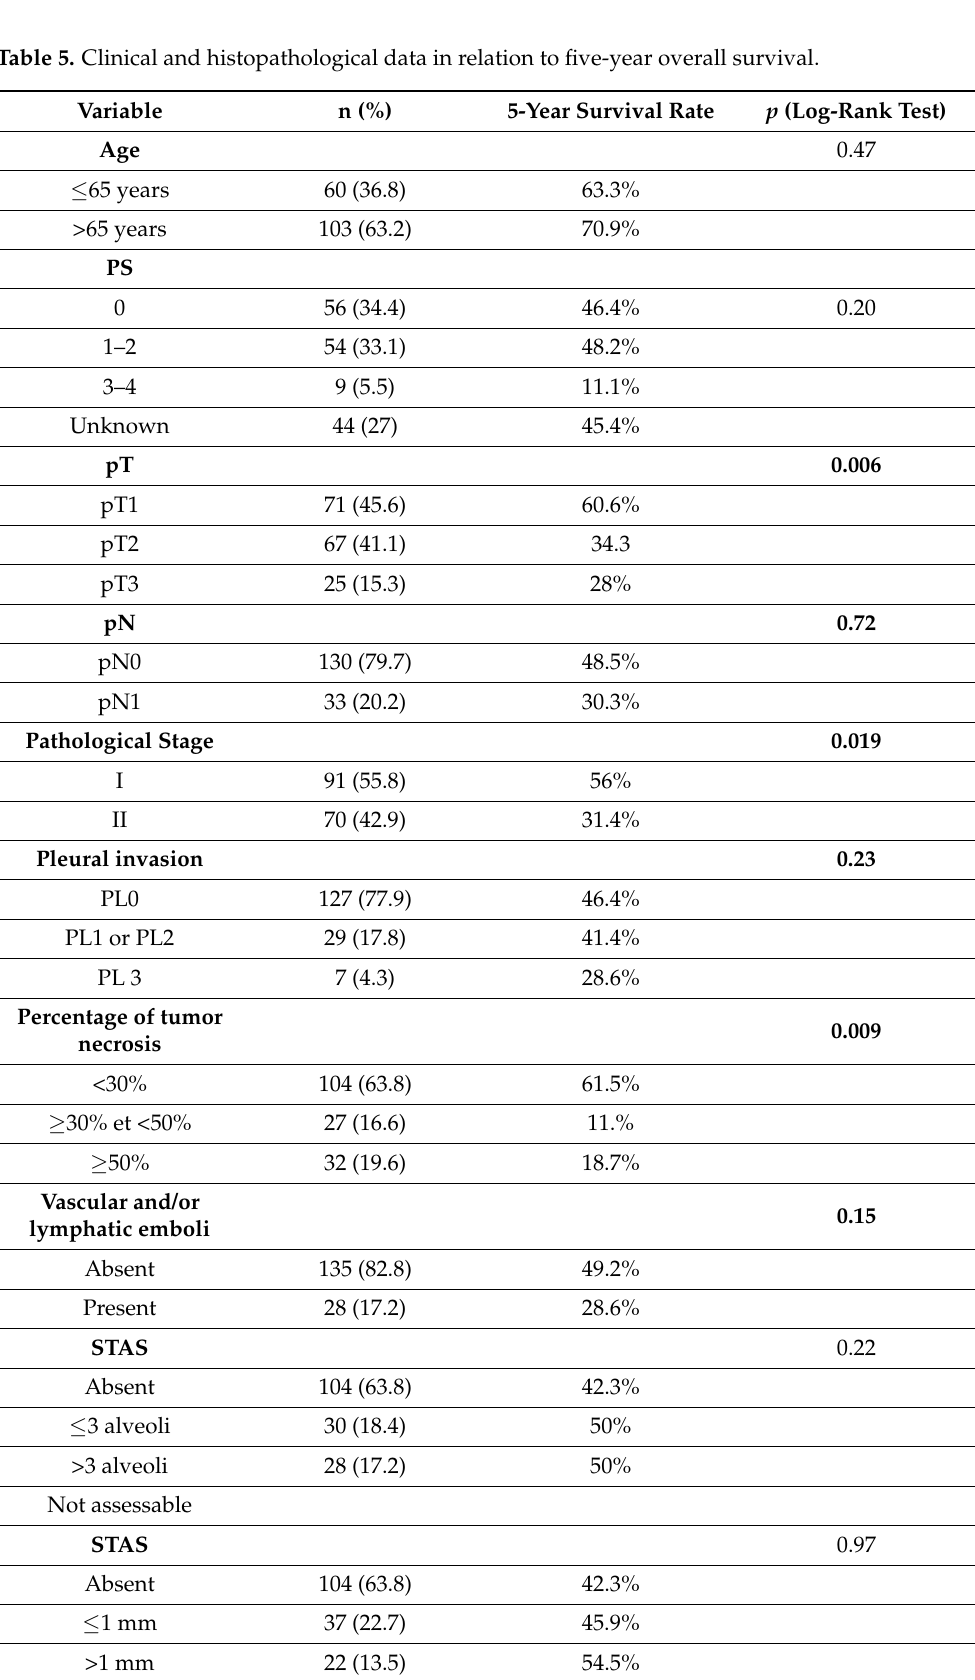
Table 5. Clinical and histopathological data in relation to five-year overall